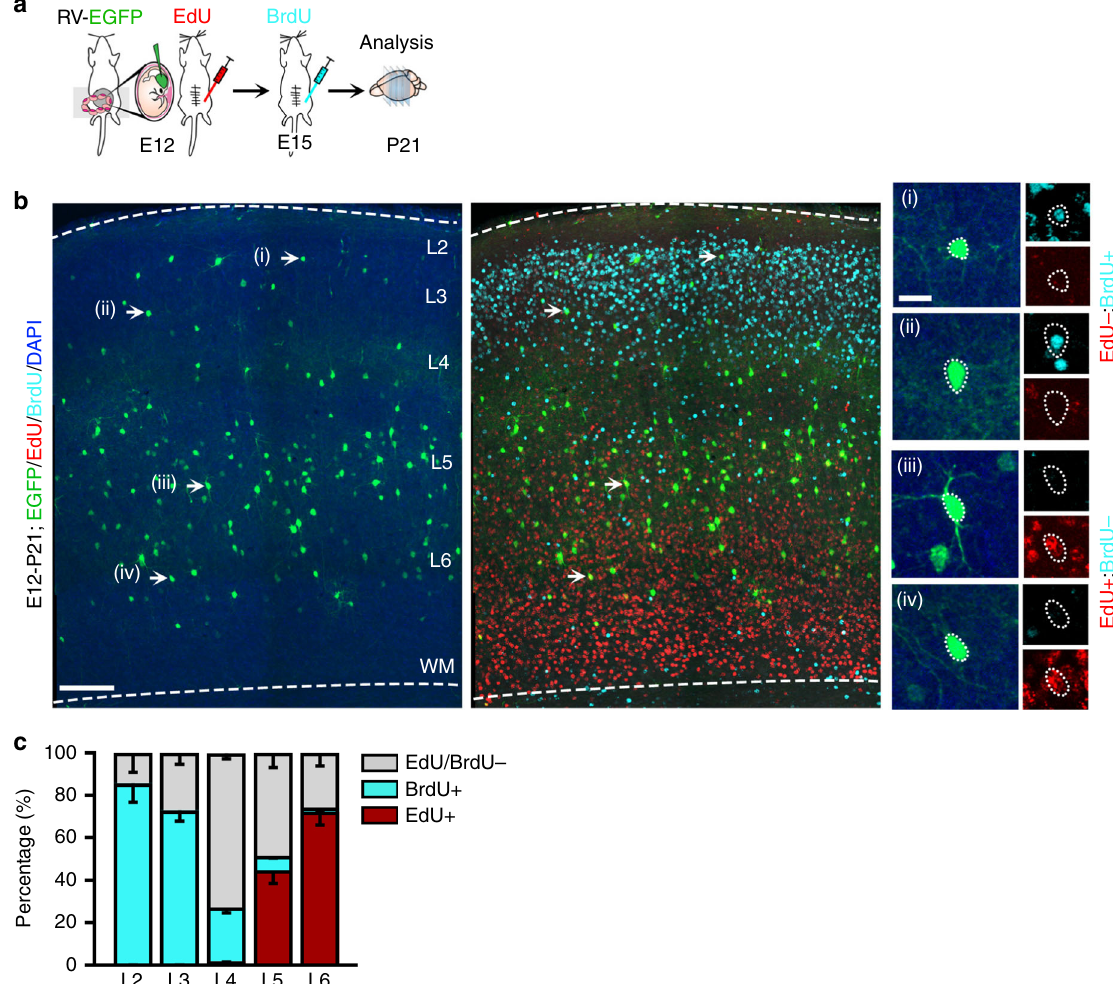
Fig. 2 Dividing NKX2.1 + MGE/PoA RGPs at E12 generate distinct neocortical interneurons at different time points. a Schematic of the experimental design. Animals received in utero injection of EGFP-expressing retrovirus, as well as EdU injection at E12 and BrdU injection at E15 were analyzed at P21. b Image of the somatosensory cortex of P21 mouse brain stained for EGFP (green), EdU (red), and BrdU (green), and counterstained with DAPI (blue). Broken lines represent the pial surface and white matter boundaries. L layer, WM white matter. High magni fi cation images of representative EGFP-expressing interneurons in different layers (arrows) are shown to the right. Scale bars: 150 μ m and 25 μ m. c Percentage of EGFP-expressing interneurons in different layers labeled with EdU or BrdU. Data are presented as mean ± SEM ( n = 3